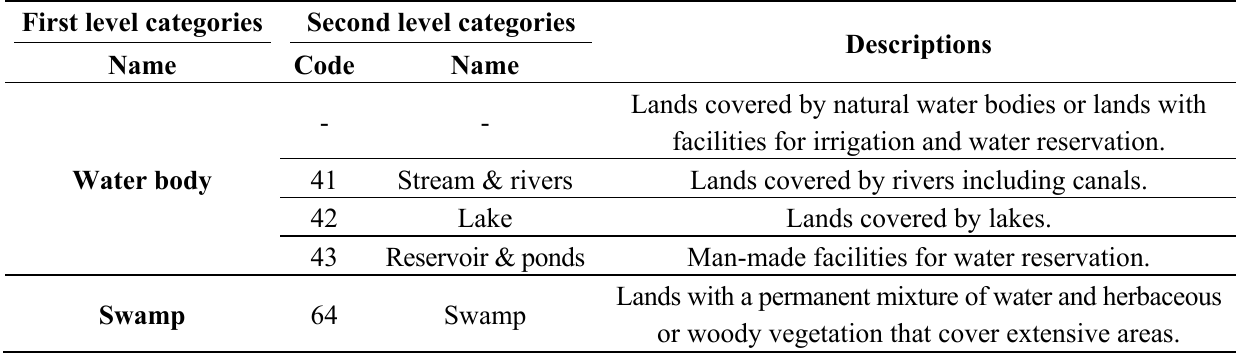
Table 1. Wetland classification and code based on remote sensing (RS)